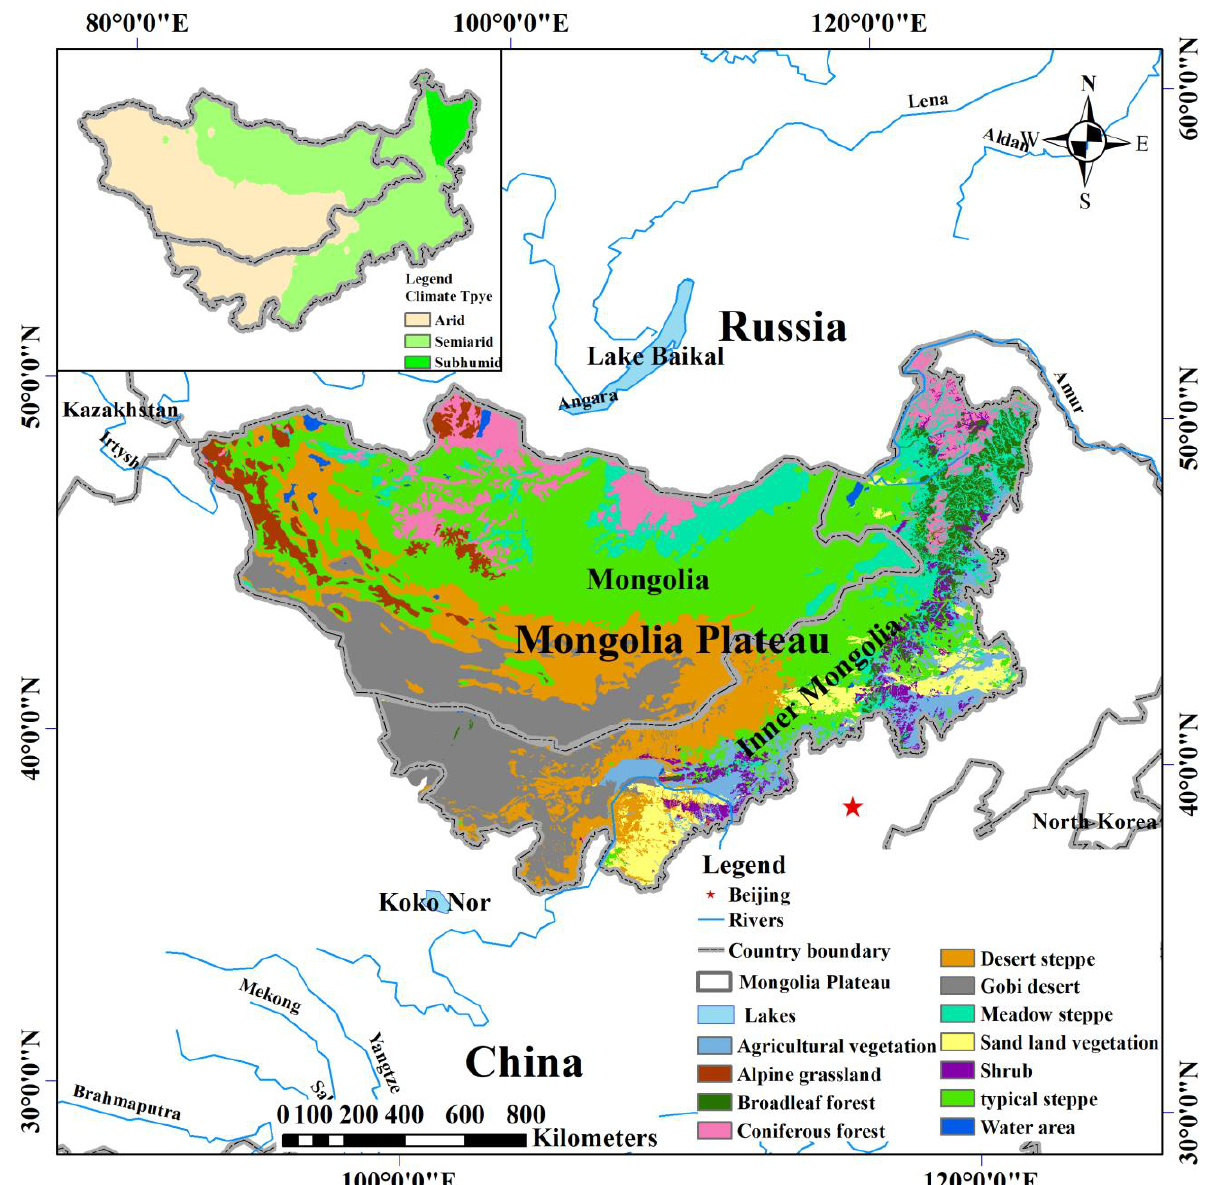
Figure 1. The study location, and the different vegetation and steppe types map of the Mongolian Plateau.